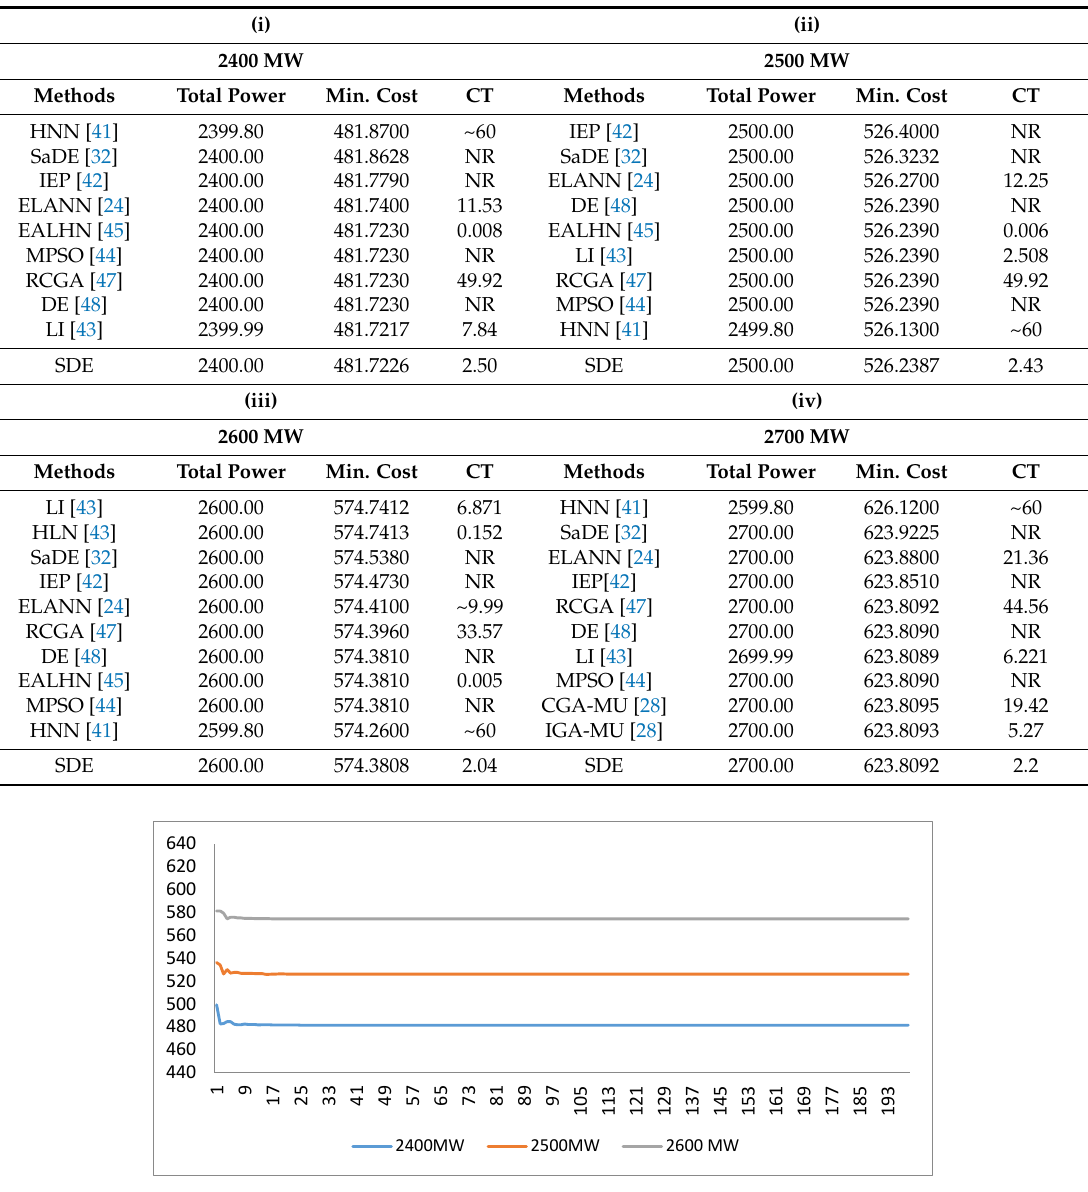
Table 5. Comprehensive comparison of total fuel cost and computation time for system 1 (without